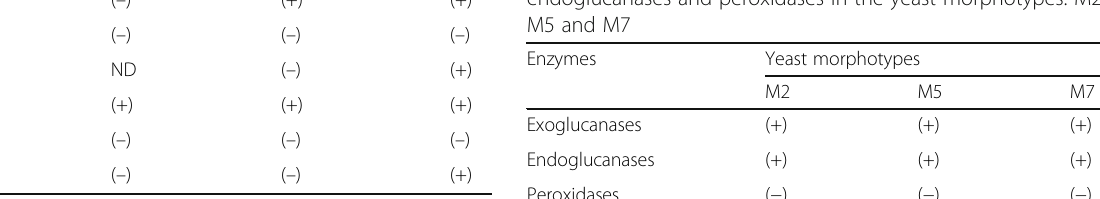
Table 2 Profile of enzymatic activity of